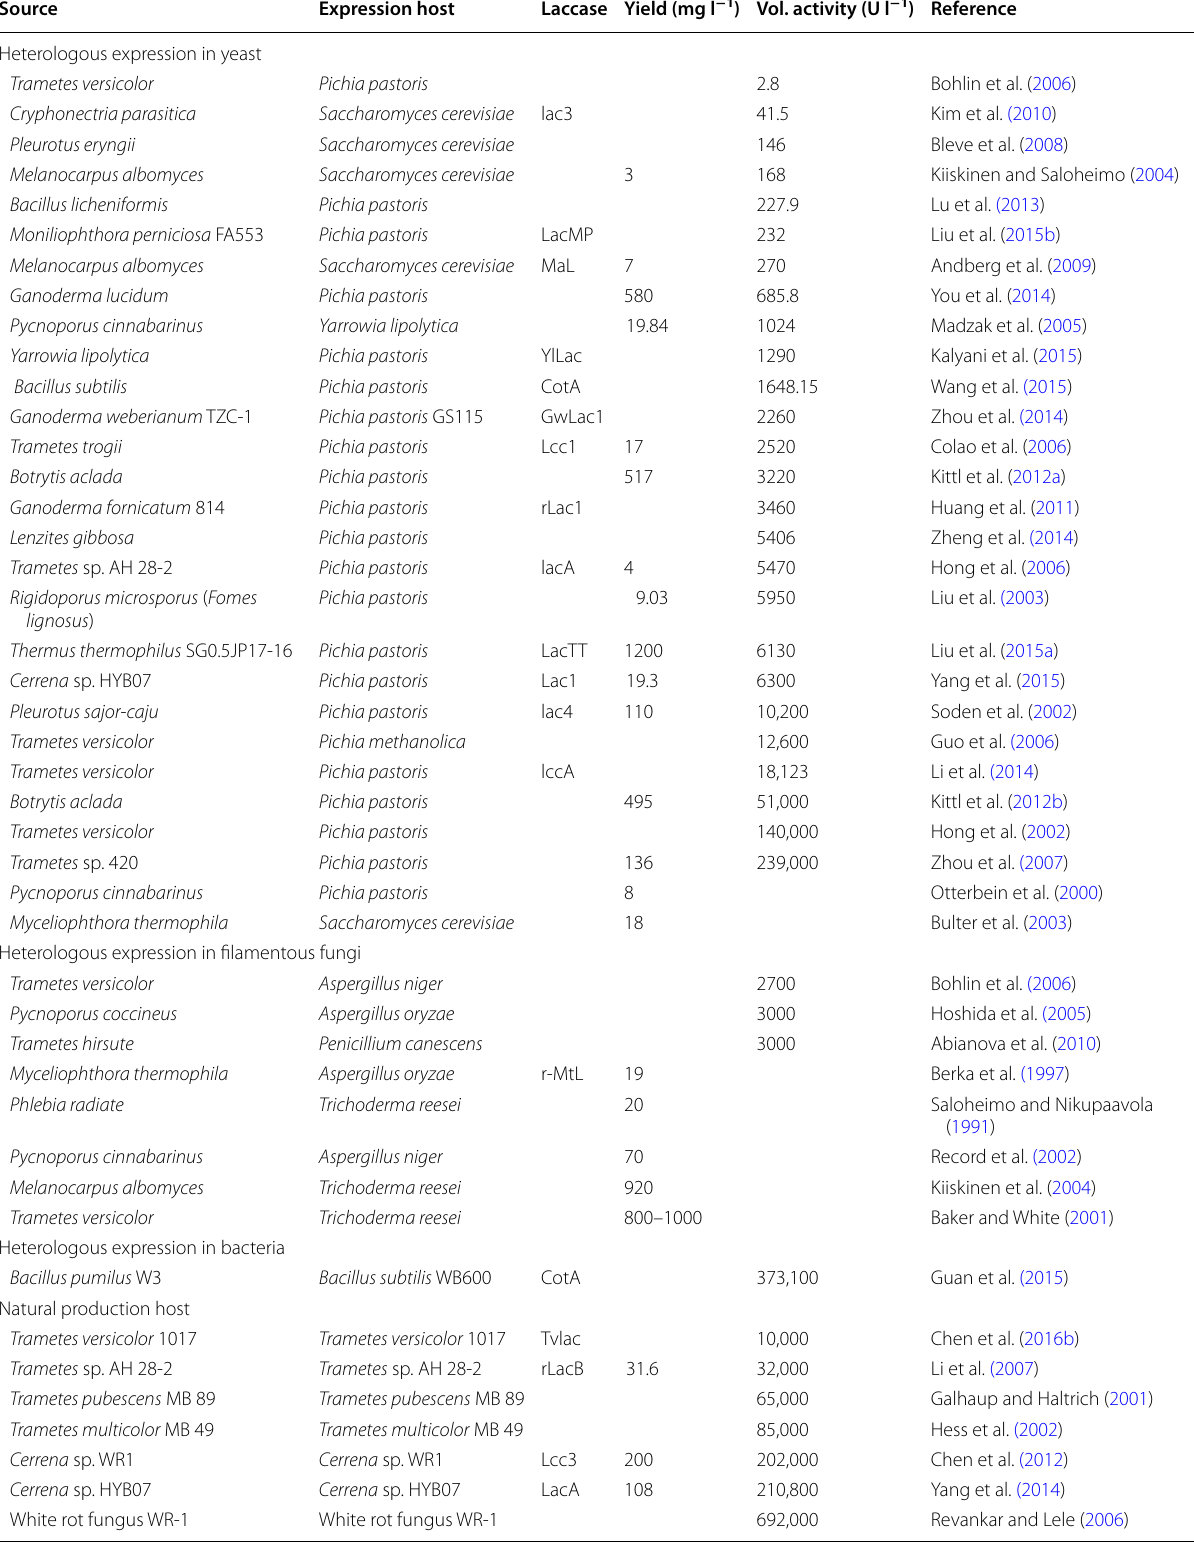
Table 5 Comparison of reported laccase yields and volumetric activity in different expression hosts